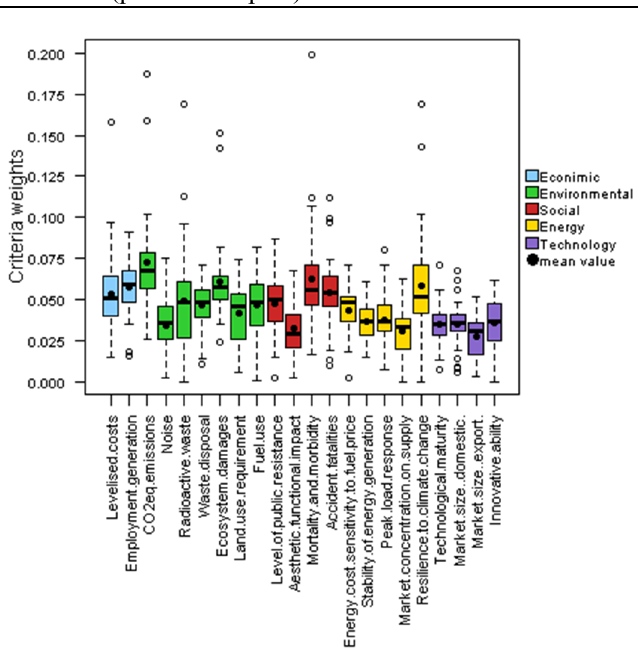
Figure 3. Boxplot with mean values of criteria weights and